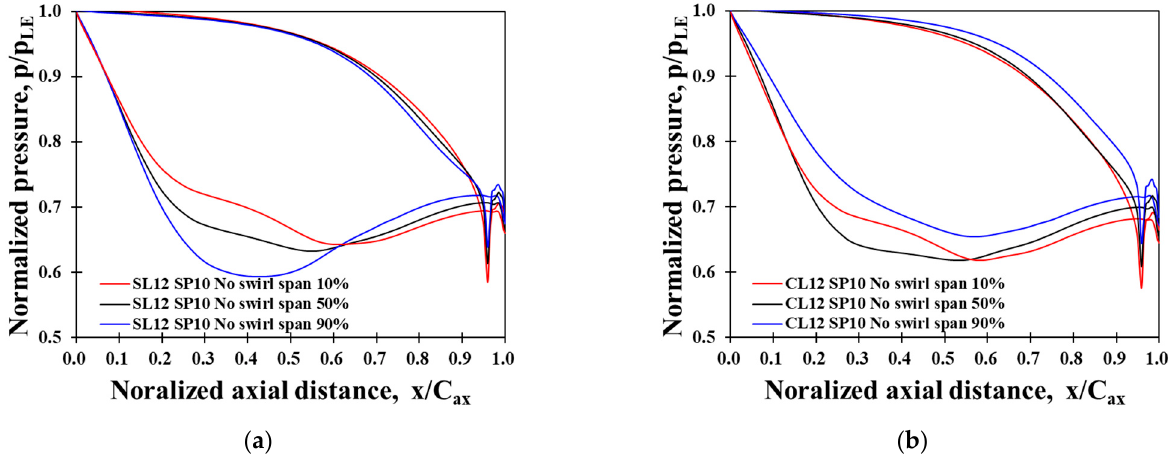
Figure 19. Comparison of NGV and Blade loading distributions of SL12 SP10 ( a ) and CL12 SP10 ( b ) models.